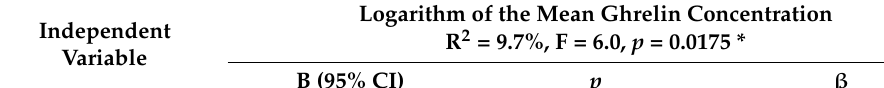
Figure 7. Night obestatin values in groups of patients with and without OSA. The interquartile range (IQR) of neuropeptide concentrations is marked with black and blue lines. Table 5. Results of regression